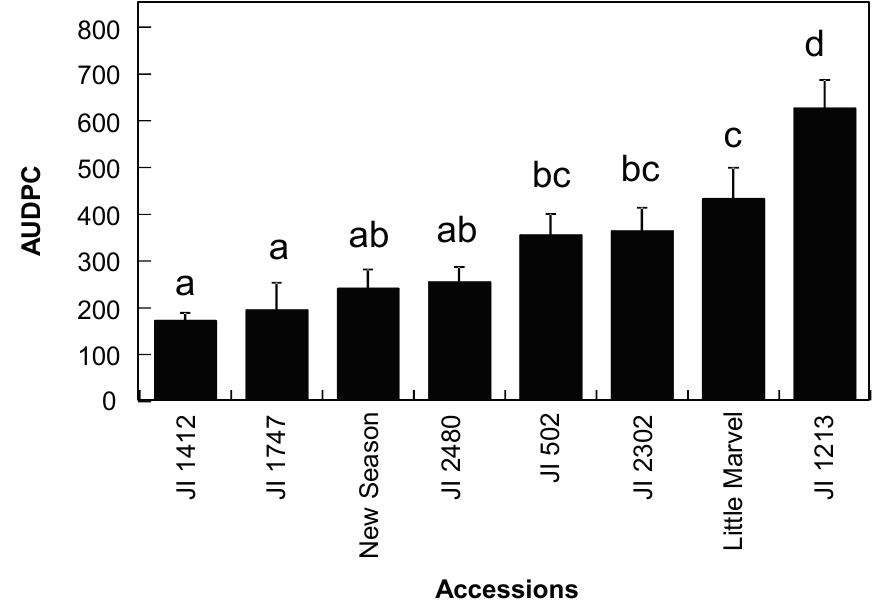
Figure 1. Assessment of Fusarium oxysporum f. sp. pisi ( Fop ) disease symptoms in the selected Pisum sativum accessions. The histogram shows the area under the disease progression curve (AUDPC) calculated for each P. sativum accession from the periodic evaluation of Fop disease symptoms expressed as percentage of wilting leaves per plant. Vertical bars are standard errors for n = 10. Different letters between each histogram indicates significant difference between values according to Duncan multiple range test at α =